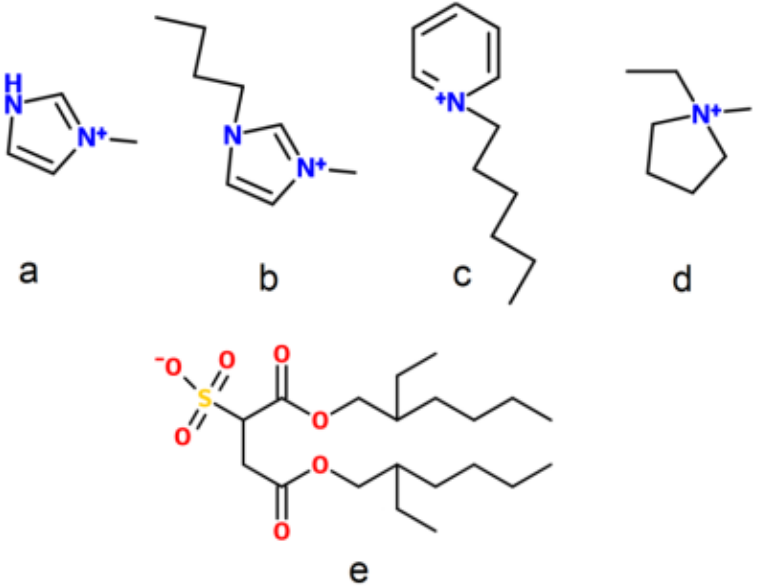
Figure 2. The structures of the cations and the [doc] anion. The abbreviations are as follows: ( a ) [mim], ( b ) [bmim], ( c ) [hpyr], ( d ) [empyrr], and ( e ) [doc].